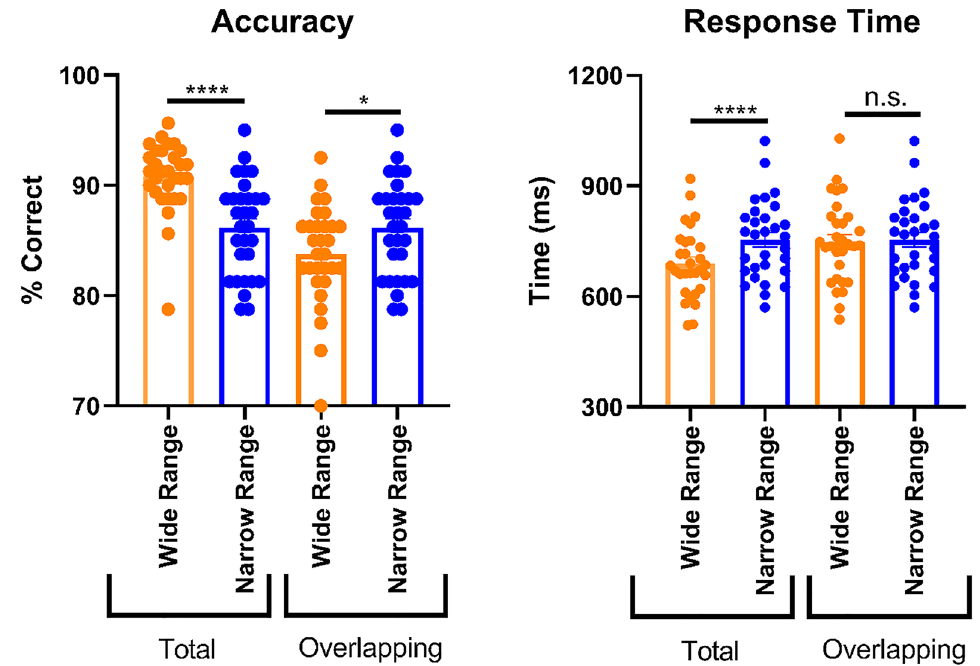
Figure 3. Accuracy and response times from Experiment 1. For accuracy, the percentage (%) correct for the wide and narrow range blocks in the experiment are given. Response time correspond to the interval (ms) from the onset of the stimulus until participants recorded their response. With both measures, the first two bars show the data for the total wide and narrow range blocks, the second two bars for only the overlapping regions of the wide and narrow range blocks. The overlapping regions are the morph percentages that the two range blocks have in common, i.e. 27.5–72.5% face. Please note that the blue data are necessarily identical and that the y-axes do not start at zero. n.s. = not significant. * = p < 0.05, **** = p < 0.0001.